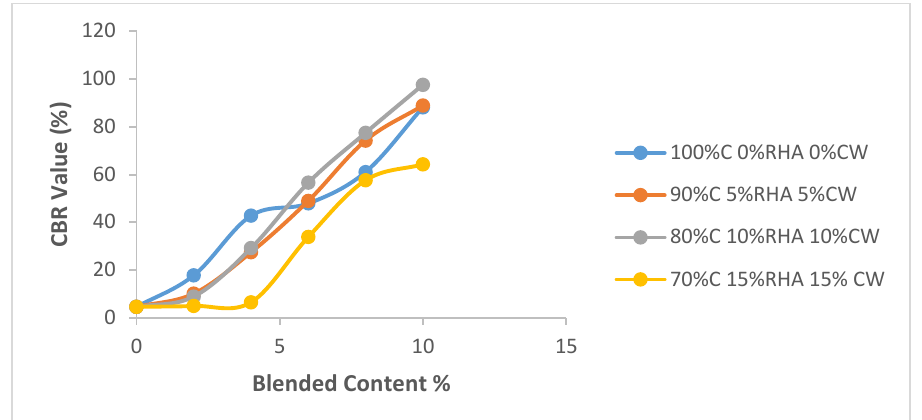
Fig. 9. Relationship between the soaked CBR value of (100%C 0%RHA 0%CW), ( 90%C 5%RHA 5%CW),(80%C 10%RHA 10%CW)& (70%C 15%RHA